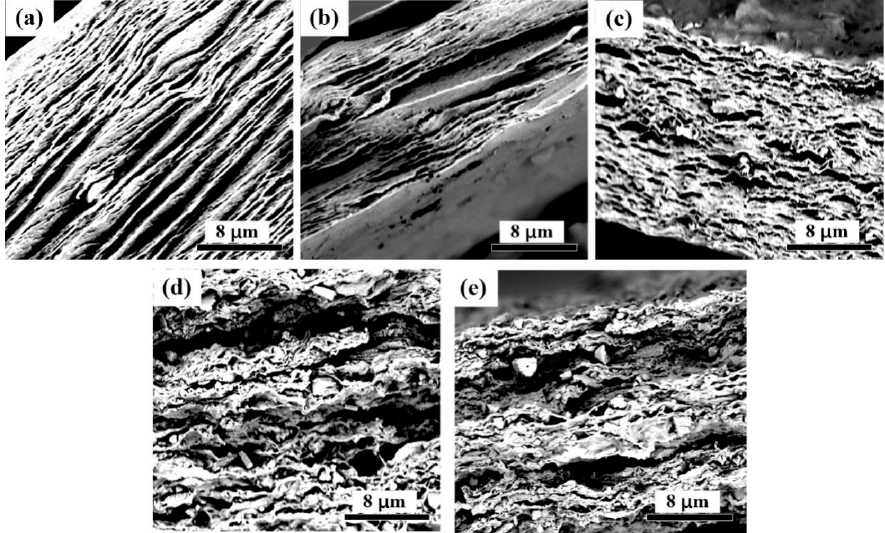
Figure 5. SEM images of the cross section of CNF-AlN composites. ( a ) Pure CNFs and CNFs containing ( b ) 2% AlN, ( c ) 5% AlN, ( d ) 10% AlN, and ( e ) 20% AlN.